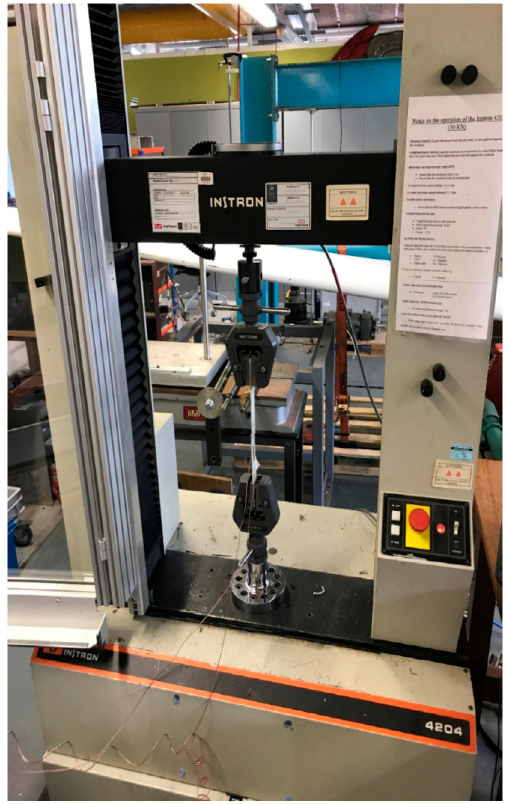
Figure 6. Instron testing machine carrying out testing.